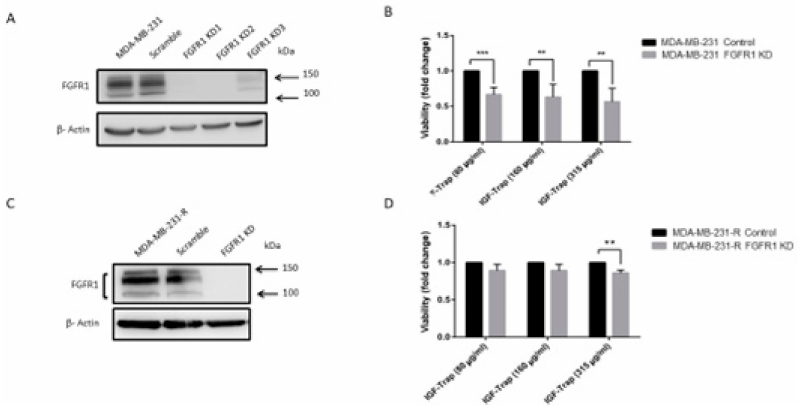
Figure 7. FGFR1 silencing enhances MDA-MB-231 cell sensitivity to the IGF-Trap. FGFR1 was silenced using lentiviral FGFR1 short hairpin RNA (shRNA). Shown in ( A , C ) are representative Western blots confirming FGFR1 silencing in MDA-MB-231 and MDA-MB-231-R cells, respectively. Cells were treated with the indicated concentrations of the IGF-Trap in the presence of serum for 48 h and proliferation ( B , D ) measured using the colorimetric MTT assay. Data are expressed as means ± SE ( n = 3), relative to controls that were assigned a value of 1. ** p < 0.01, *** p <